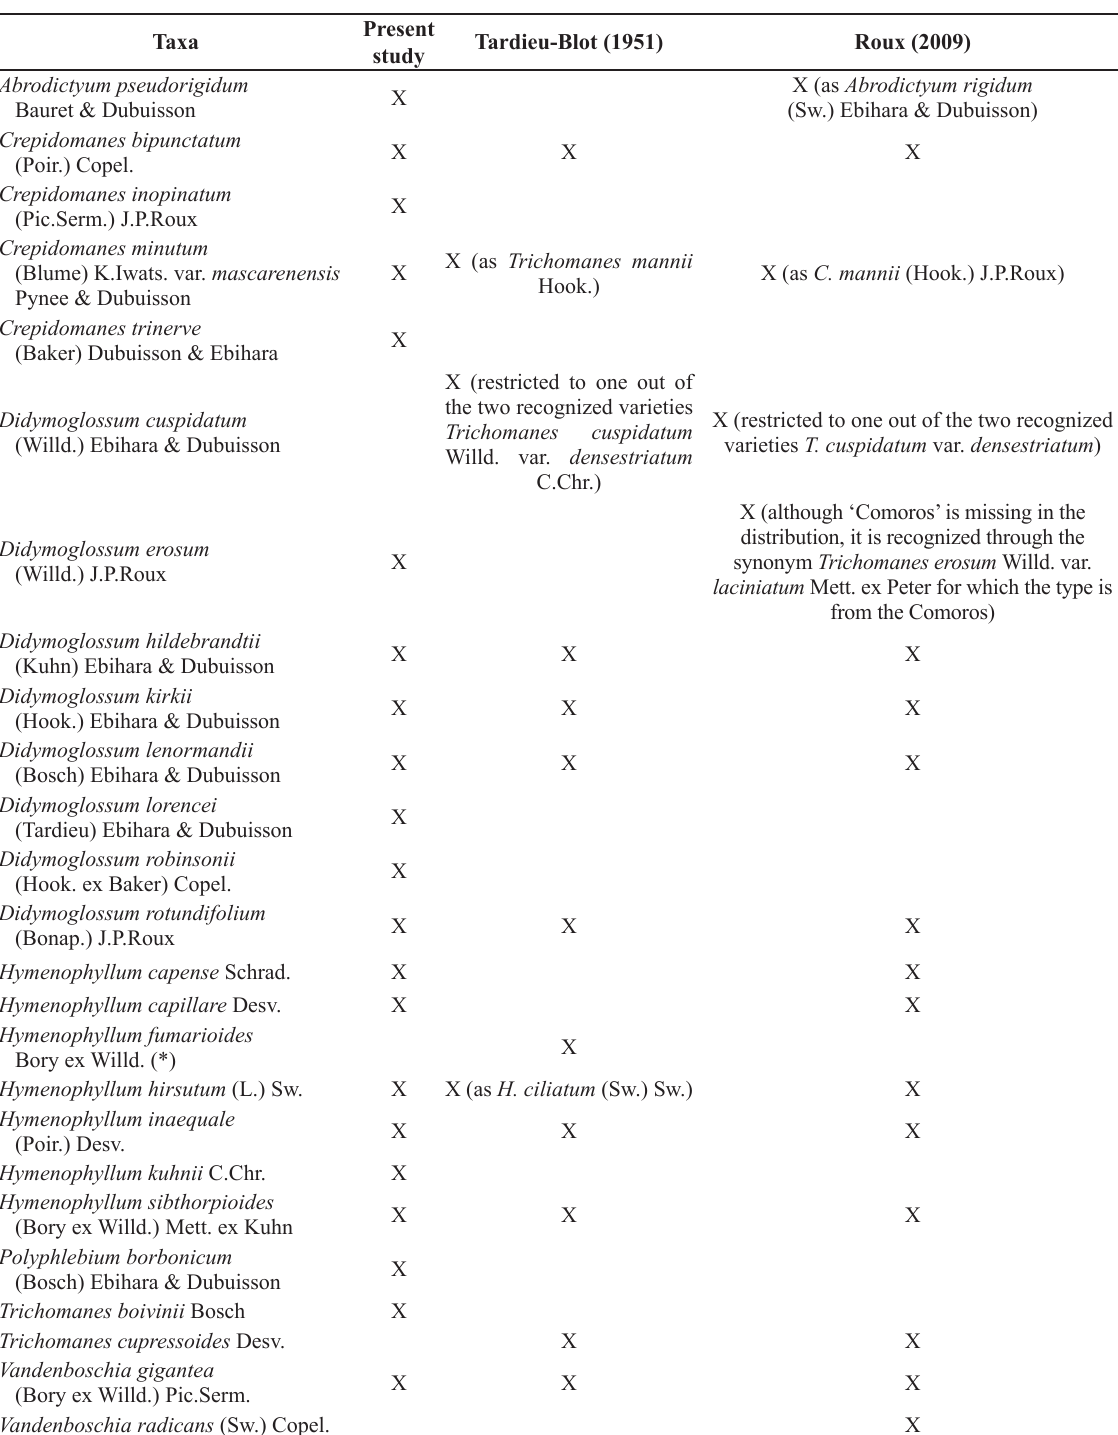
Table 1. List of Hymenophyllaceae species recorded for the Comoros archipelago and comparison with previous studies; all species in Tardieu-Blot (1951) were reported by her as belonging to Trichomanes or Hymenophyllum , following the traditional bi-generic classification of Hymenophyllaceae. (*) Synonym of Hymenophyllum tenellum (Jacq.) Kuhn, but most specimens in collection identified as H. fumarioides Bory ex Willd. would be in fact H. capense Schrad. (as discussed on p. 26). X = present or reported